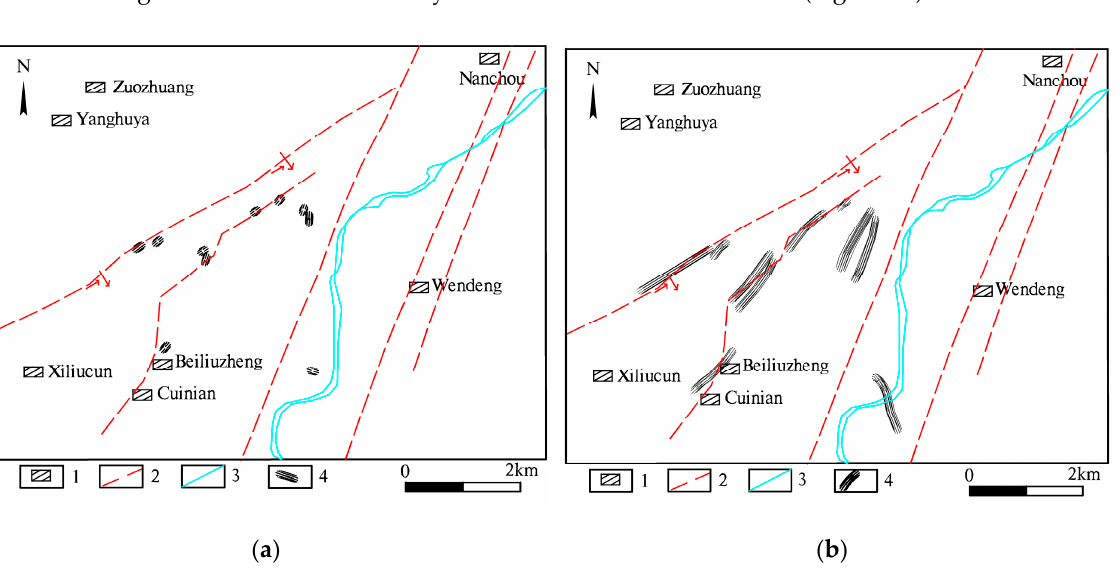
Figure 7. Tracing trajectory of tracer particles. ( a ) 100 day, ( b ) 1000 day; 1: Village; 2: Fault; 3: River; 4: Migration trajectory.